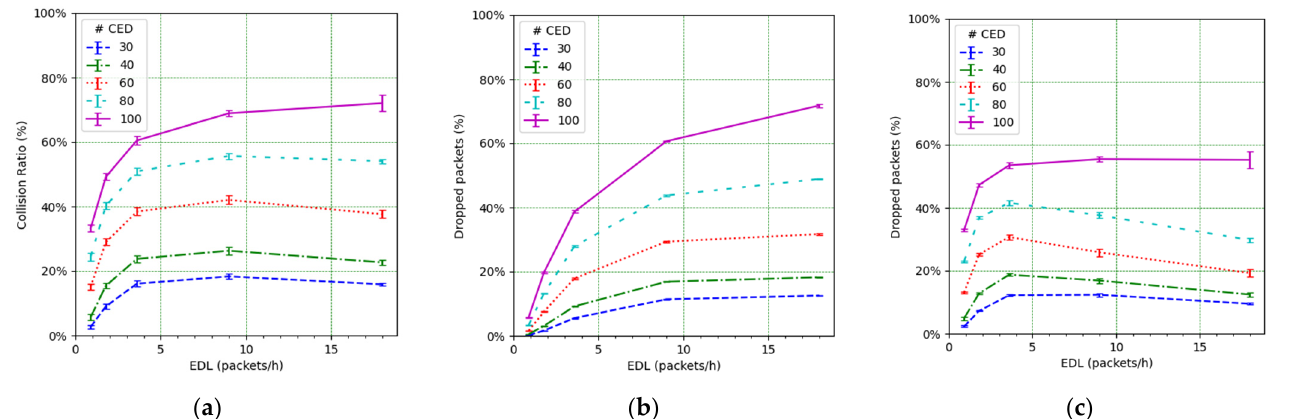
Figure 13. ( a ) Collision ratio at the gateway. ( b ) Packet drop ratio at EDs due to duty cycle restrictions. ( c ) Packet drop ratio at the gateway due to duty cycle restrictions.